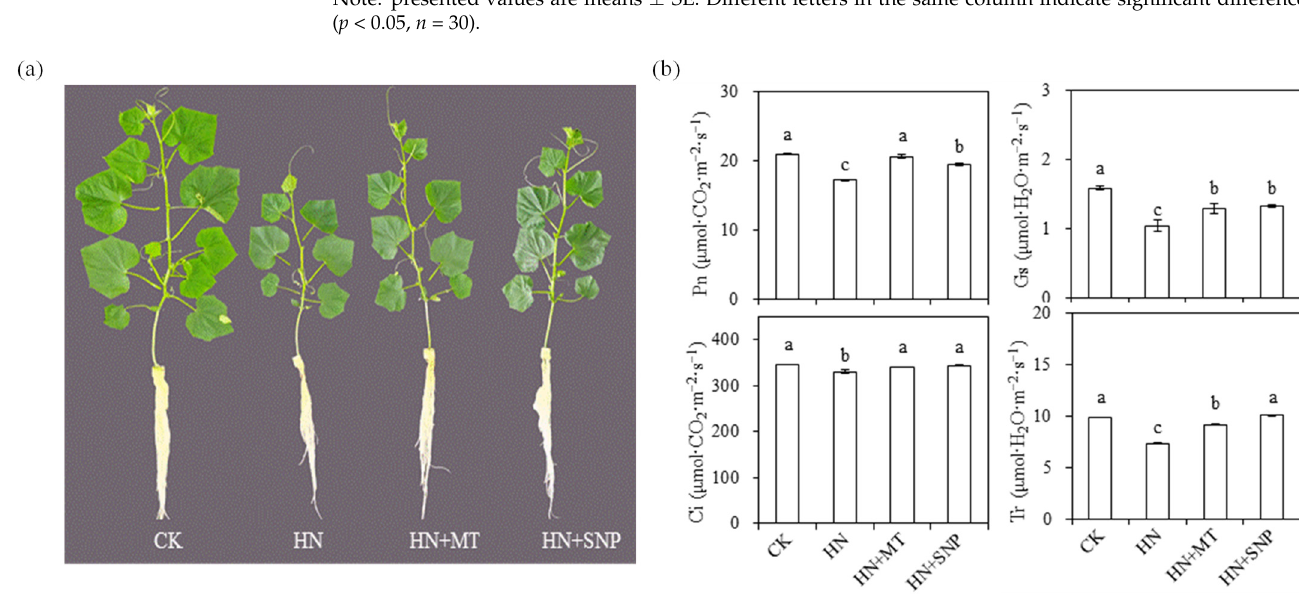
Note: presented values are means ± SE. Different letters in the same column indicate significant differences ( p < 0.05, n = 30).